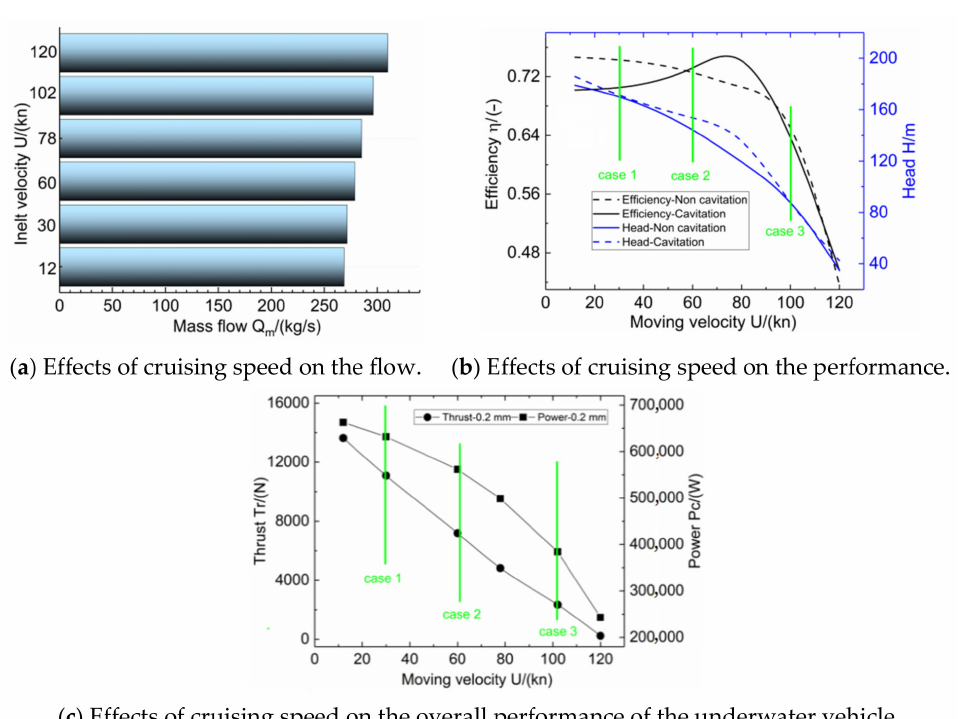
Figure 6. Evaluation of the cruising speed on the key